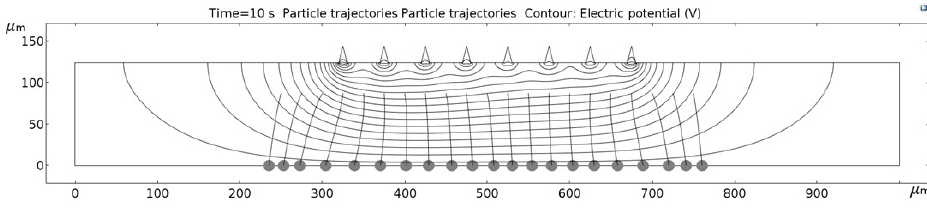
Figure 14. Computed particle trajectories and electric potential for the Notch electrode geometry.